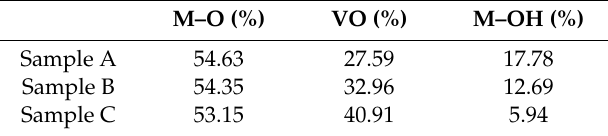
Figure 3. Measured output characteristic curves of samples ( a ) A, ( b ) B, and ( c ) C with different V GS values. Table 2. X-ray photoelectron spectroscopy (XPS) measurement of O 1s spectra of the three samples.